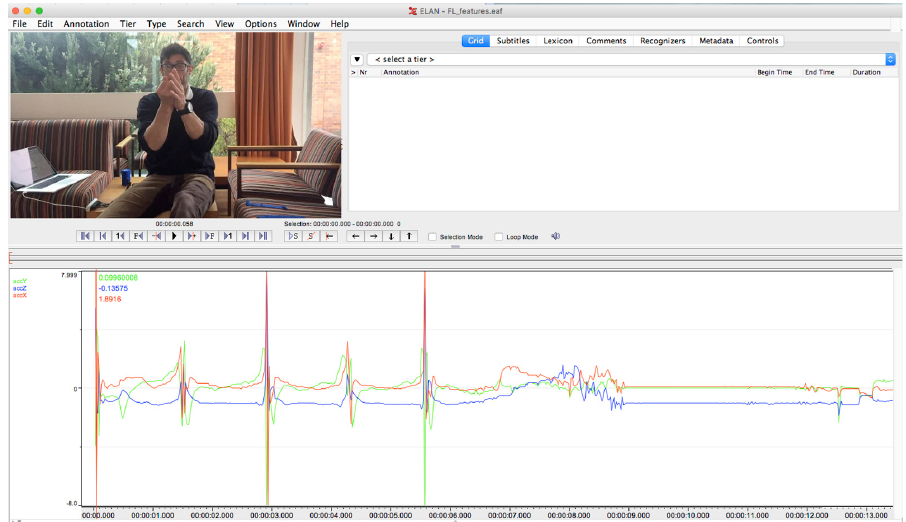
Figure 2. Sensors and video were synchronized on short successive taps, which appear as sharp spike in the accelerometer data stream.